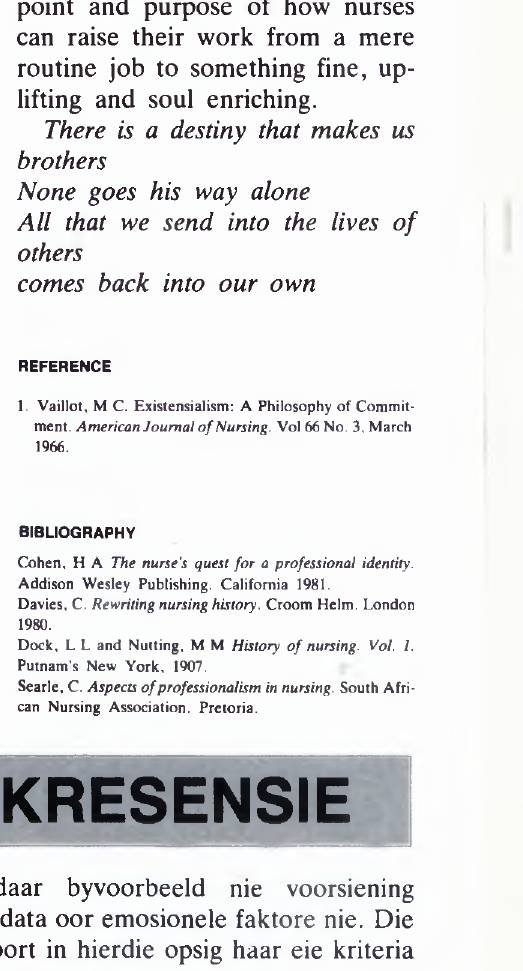
voorsiening verpleegster behoort in hierdie opsig haar eie kriteria op te stel. Hierdie is nogtans ’n boek van groot praktiese w aarde wat elke verpleegkundige behoort te lees en